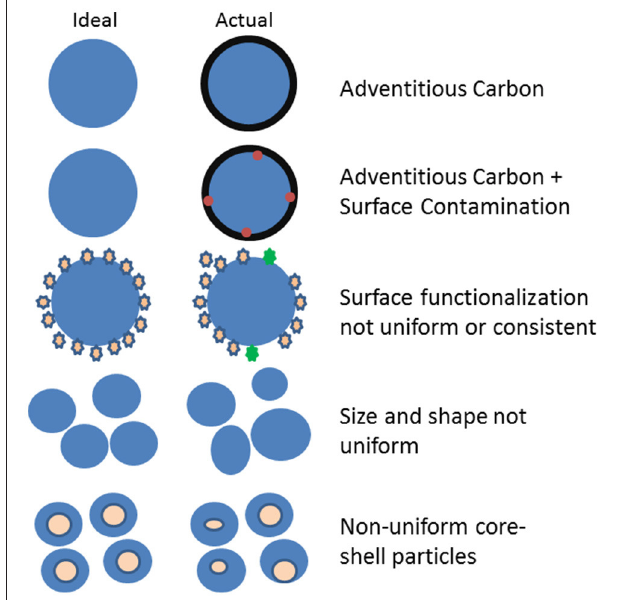
FIGURE 1 | Examples of ways that NPs differ from the ideal or intended synthesis